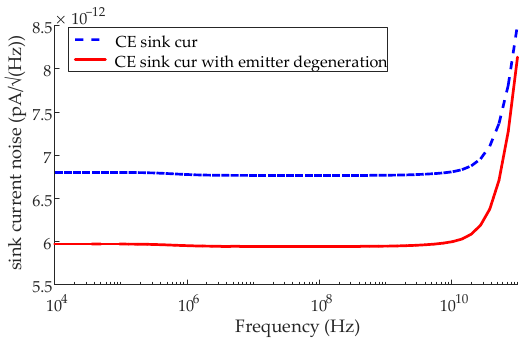
Figure 17. Simulated input-referred noise current introduced by the sink currents.